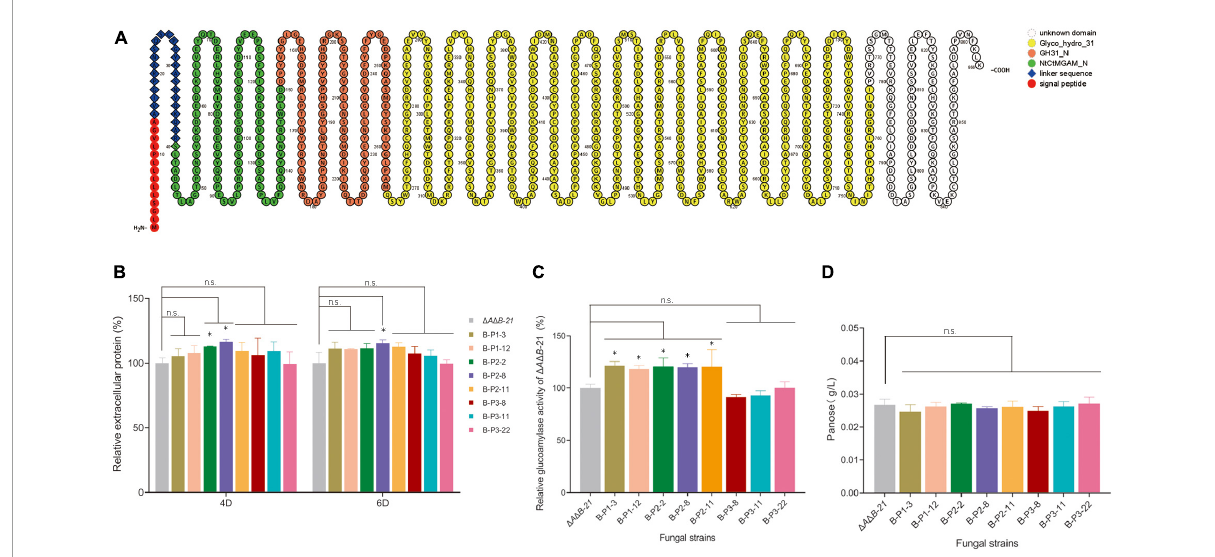
FIGURE3 Domain architecture of A. niger agdB and effects of overexpressing different domains in strain (cid:49) A (cid:49) B -21 on extracellular protein levels, glucoamylase activity, and transglycosylation activity. (A) Schematic representation of agdB created using Protter protein visualization tool (Omasits et al., 2014). (B) Extracellular protein levels in supernatants of 4-day and 6-day shake-flask fermentation cultures of (cid:49) A (cid:49) B -21 and domain-overexpressing (OE) strains. Relative extracellular protein = extracellular protein level in supernatant of engineered strain compared with that in supernatant of strain (cid:49) A (cid:49) B -21. (C) Glucoamylase activity assay in supernatants of 6-day shake-flask fermentation cultures of (cid:49) A (cid:49) B -21 and domain-OE strains. Relative glucoamylase activity = glucoamylase activity in supernatant of engineered strain compared with that in supernatant of strain (cid:49) A (cid:49) B -21. (D) Concentrations of sole product, panose, in reaction mixture as detected by HPLC. Values are means ± SD ( n = 3 repeats). ∗ P < 0.05 (Student’s t -test), n.s., not